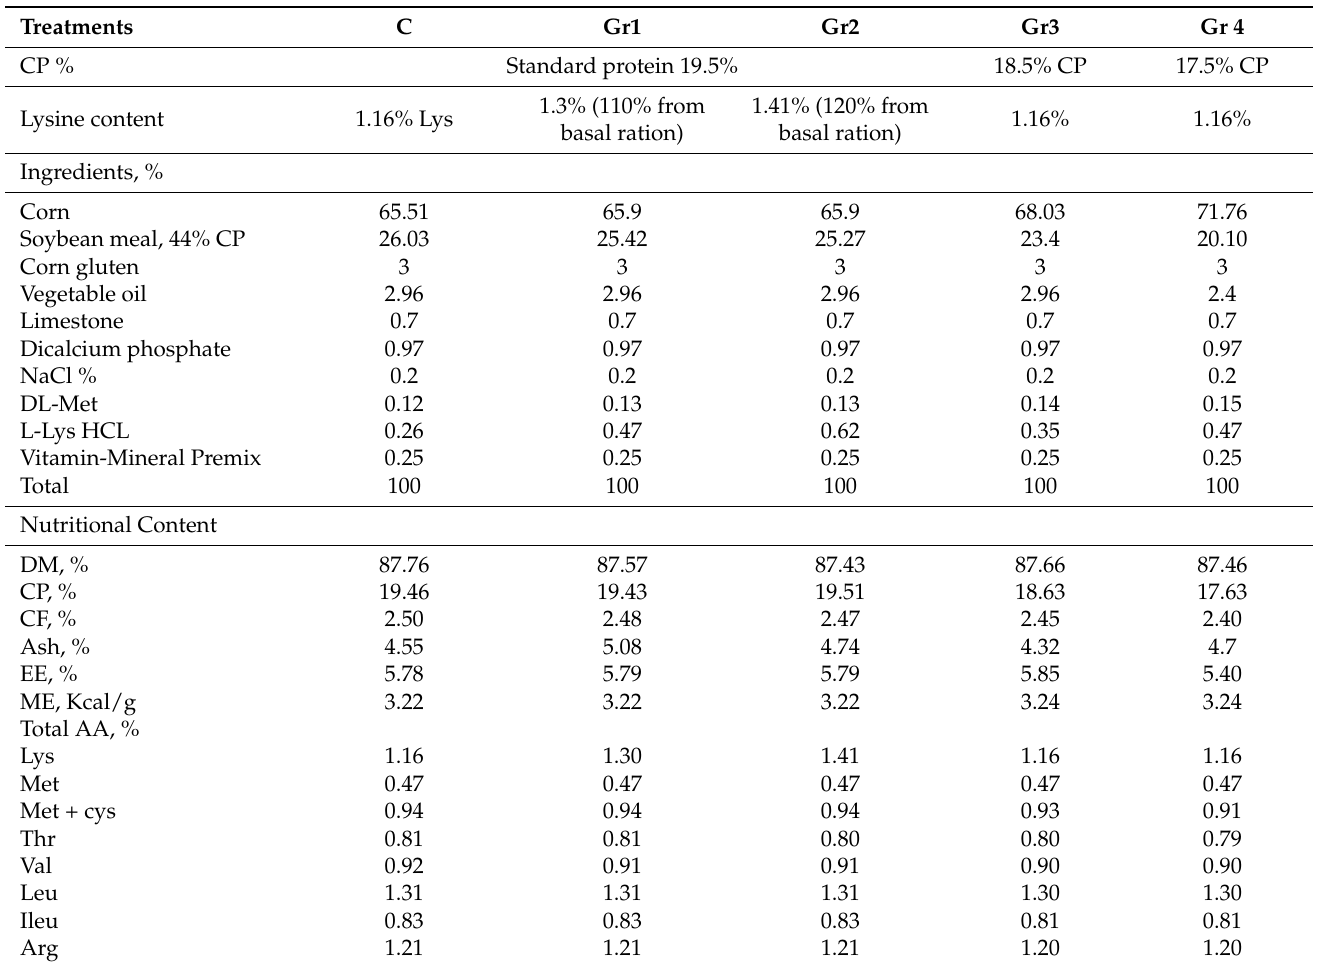
Table 3. The composition of the experimental diets and proximate chemical analysis during the finishing